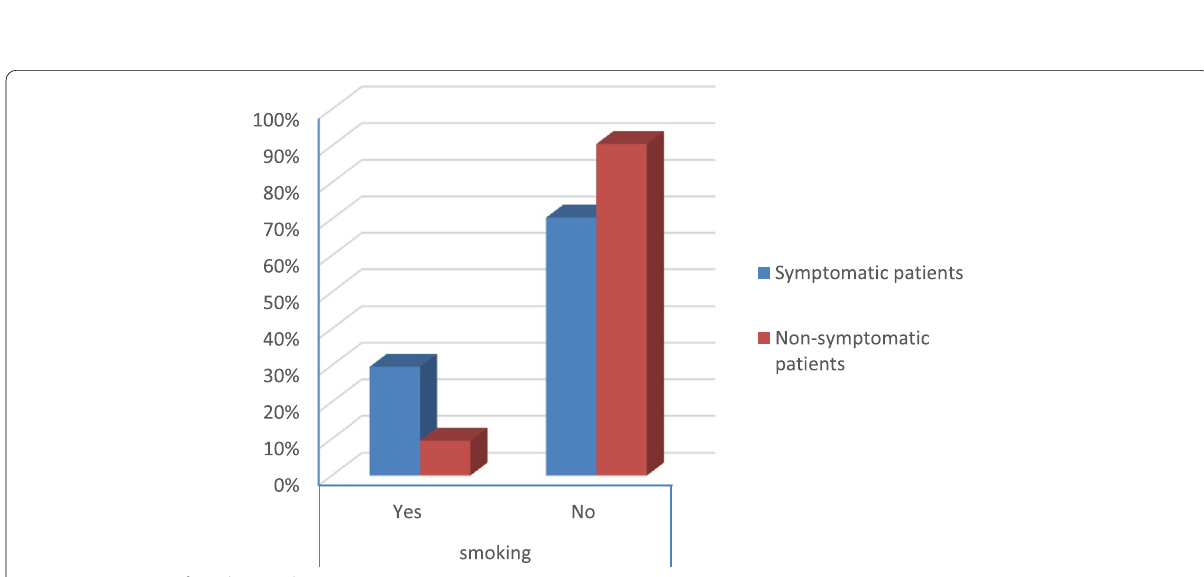
Fig. 9 Percentage of smoking in the